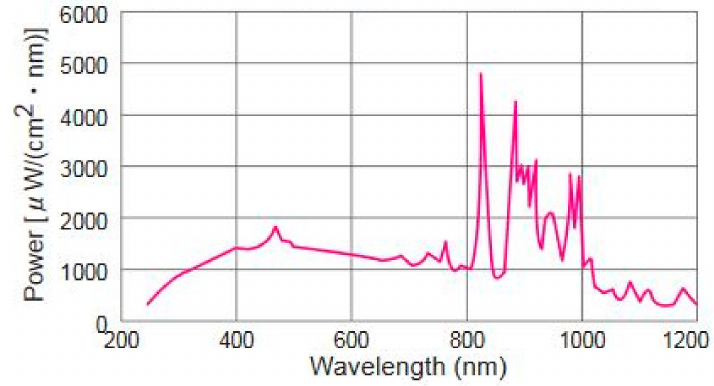
Figure 2. The spectral intensity of Xe light